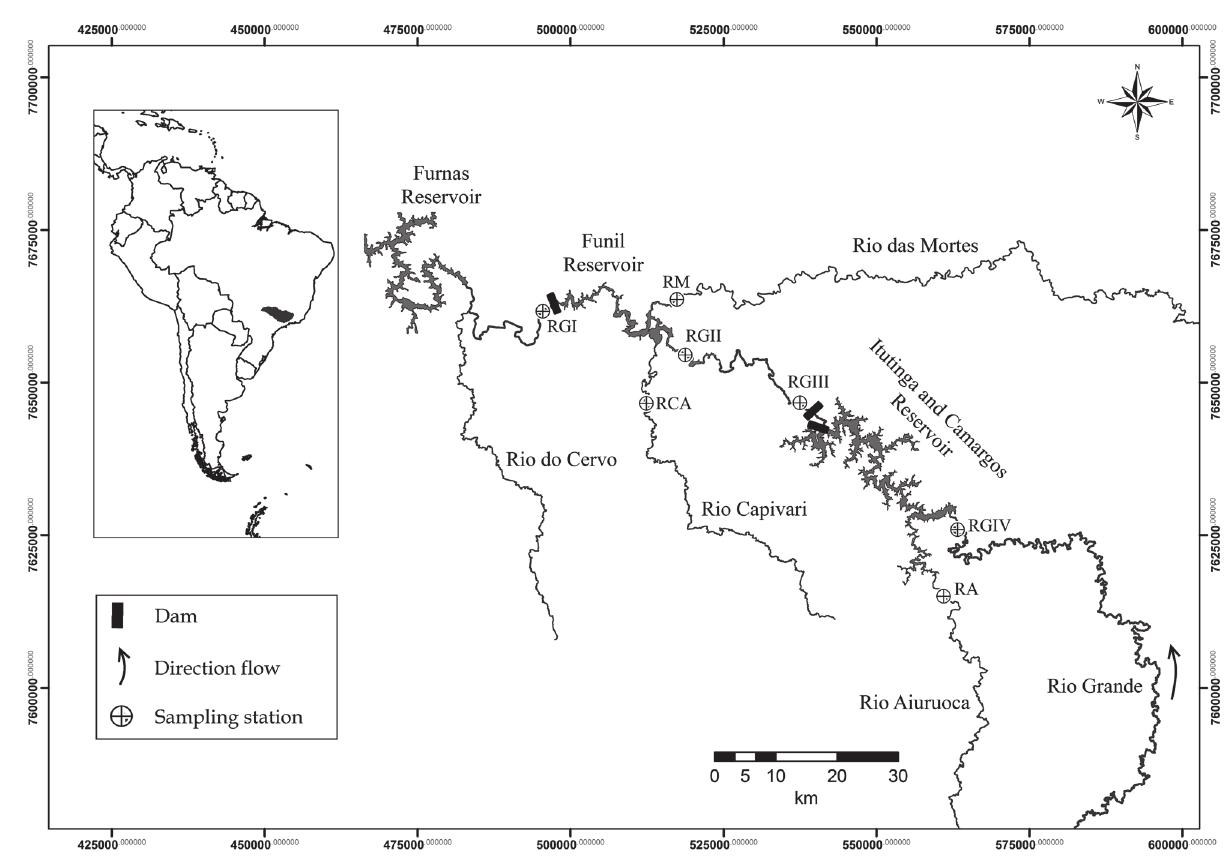
Fig. 1. Locations of sampling stations in the upper rio Grande basin upstream of the Furnas Reservoir (Minas Gerais State, Brazil). RGI = immediately downstream of the Funil Dam; RGII = immediately upstream of the Funil Reservoir; RGIII = immediately downstream of the Itutinga Dam; RGIV = immediately upstream of the Camargos Reservoir; RCA = Capivari River; RM = Mortes River; and RA = Aiuruoca